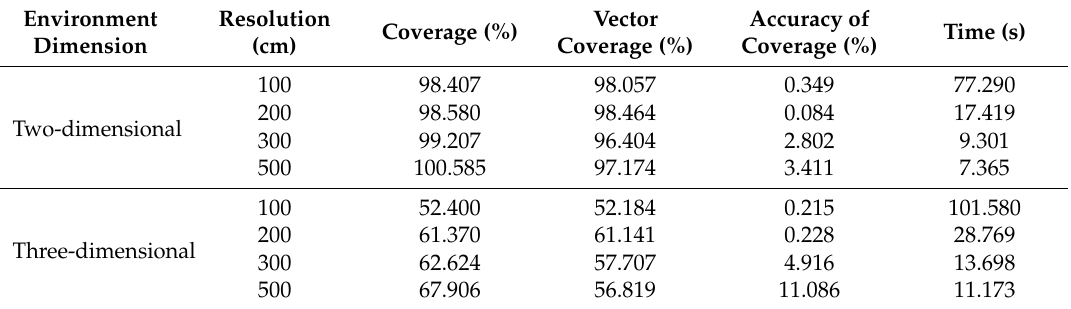
Table 4. Values obtained based on VFCPSO algorithm for two- and three-dimensional